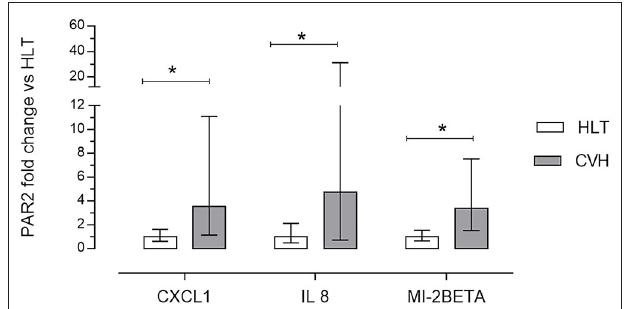
FIGURE 6 | Array validation using quantitative real-time polymerase chain reaction (RT-qPCR) of C-X-C motif ligand 1 (CXCL1), interleukin 8 (IL8) and macrophage inflammatory protein 2 beta (MI-2BETA) in the colon mucosa of the healthy horses (HLT group, n = 8) or in the colon mucosa of the horses with volvulus (CVH group, n = 8). The relative mRNA expression (fold of change) was calculated in relation to the HLT sample using the 2 − 11 ct method. Data represent the mean ± the range of relative expression of eight biological replicates; each experiment was repeated twice. The data were analyzed using the Student’s t -test. Significant differences are indicated by * p <